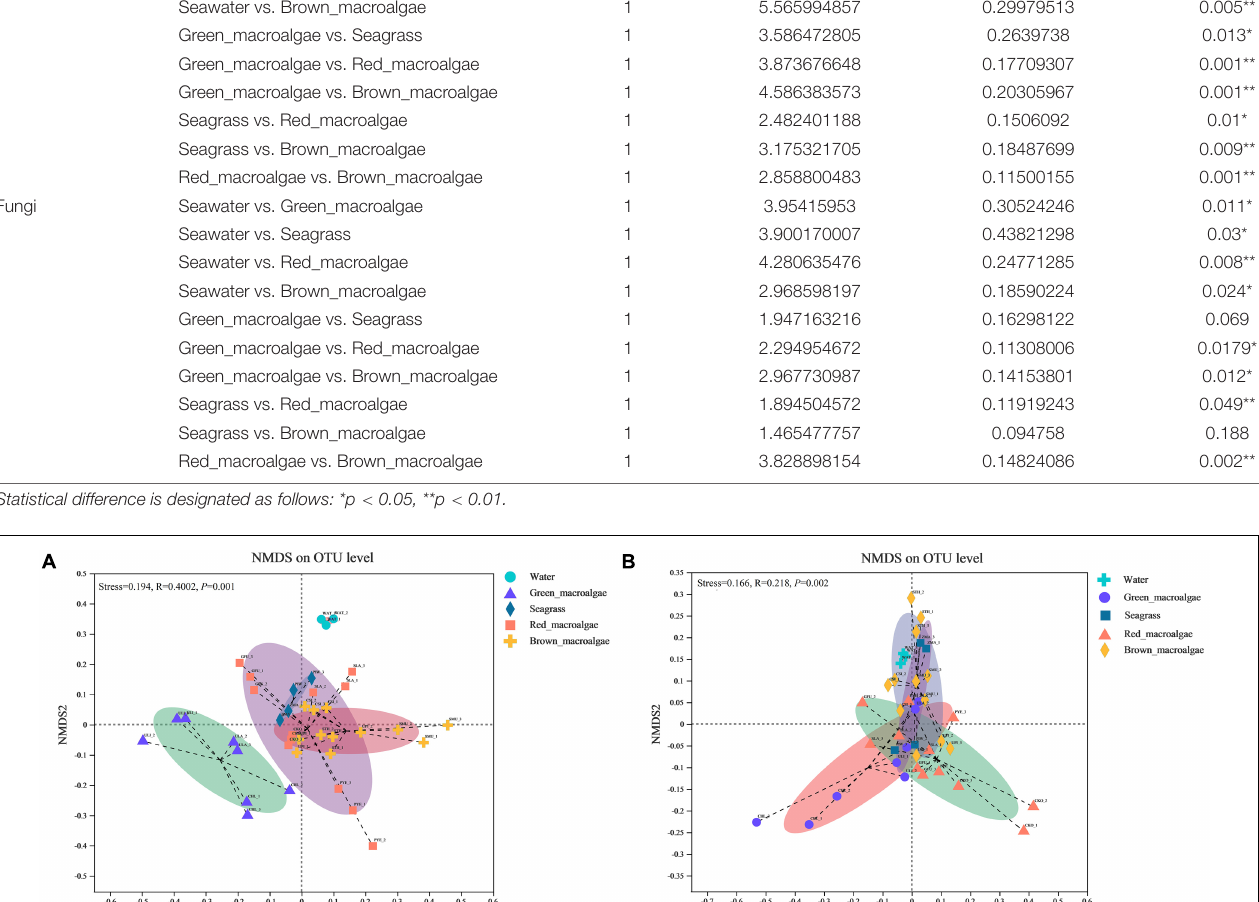
( Figure 6B and Supplementary Figure 3 ). At the genus level, the genera Alternaria , Metschnikowia, and Erythrobasidium were significantly higher in seagrass while Naganishia was significantly higher in red